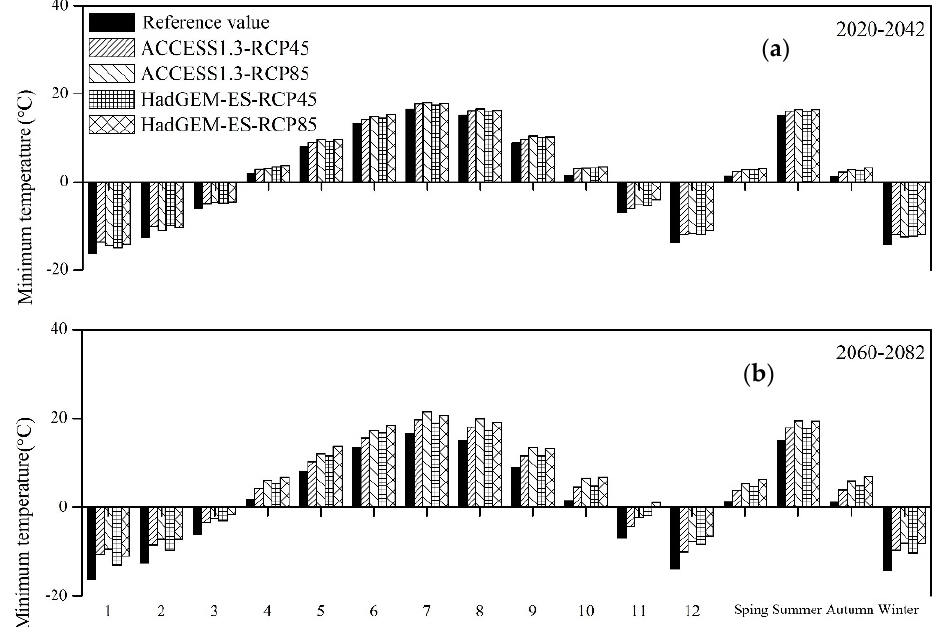
Figure 6. Projected values of minimum temperature under the different combinations of GCMs and RCPs scenarios during the different assessment periods ( a ) from 2020 to 2042; ( b ) from 2060 to 2082.